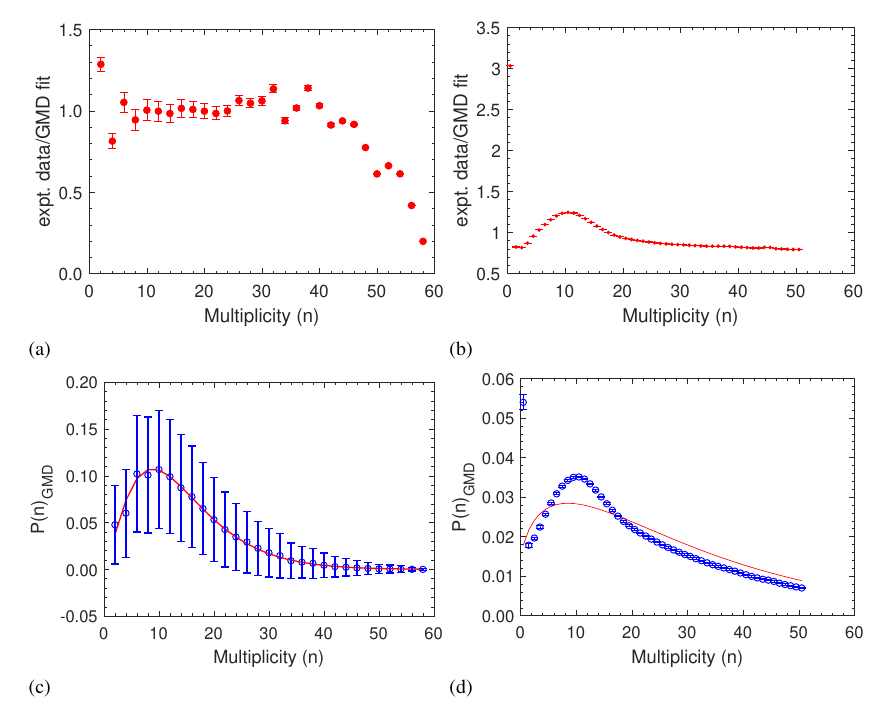
Figure 2. (a) Data to GMD fit ratio corresponding to multiplicity at √ s = 0.2 TeV with GMD parame- ters k = 1.67, k ′ = 1 and ¯ n = 14.36. (b) Data to GMD fit ratio corresponding to multiplicity at √ s = 7 < 2 and GMD parameters k = 1.41, k ′ = 0 and ¯ n = 31. (c) Comparison η TeV with pseudorapidity range | | between data (circles) and GMD fit (line) at √ s = 0.2 TeV for p ¯ p collisions with GMD parameters k = 1.67, k ′ = 1 and ¯ n = 14.36. (d) Comparison between data (circles) and GMD fit (line) at √ s = 7 TeV < 2 for pp collisions with GMD parameters k = 1.41, k ′ = 0 and ¯ n = η and pseudorapidity range | |